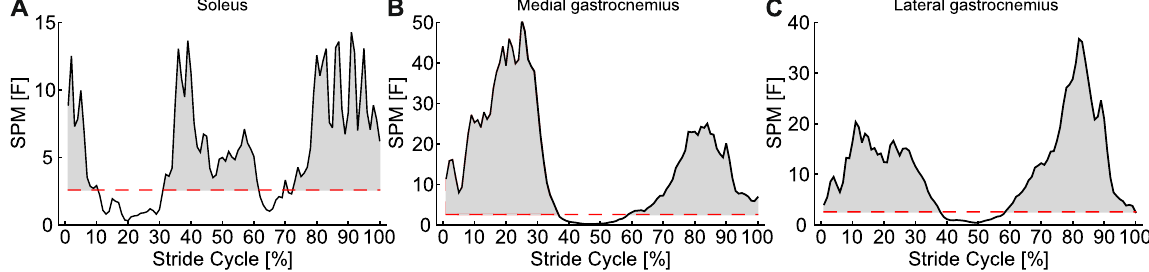
Figure 3. SPM ANOVA results for ( A ) soleus, ( B ) medial gastrocnemius and ( C ) lateral gastrocnemius, showing where significant differences in thickness at different muscle regions occur as a function of stride cycle